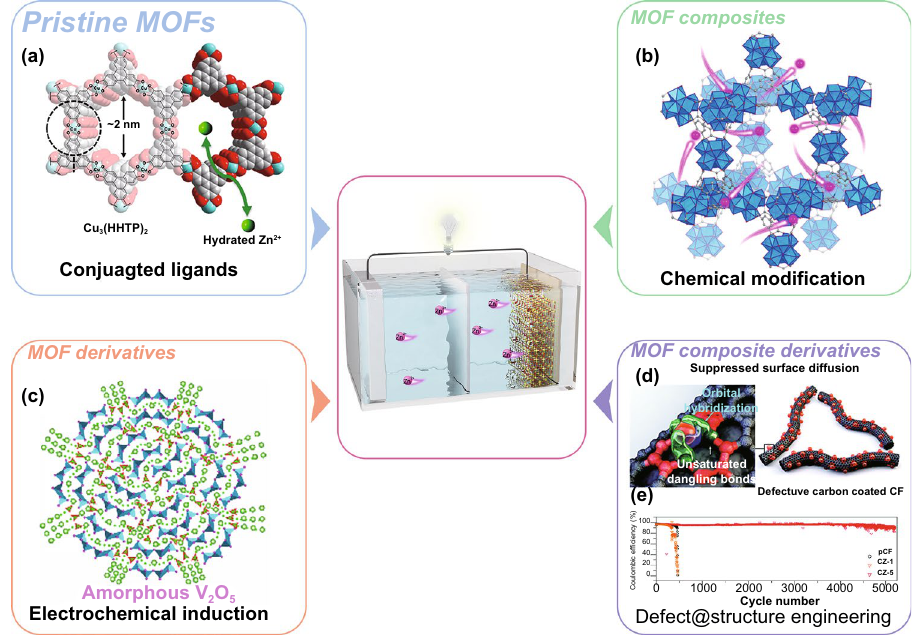
Fig. 5 MOF-based materials for ZIBs. a Crystal structure (the cyan, red, and gray spheres represent Cu, O, and C atoms, respectively) of Cu 3 (HHTP) 2 [164]. Copyright © 2019, Nature Publishing Group. b Crystal structure of ZnMOF-808. Blue polyhedrons represent Zr-O clusters and pink balls represent Zn 2+ ions [168]. Copyright © 2019, Elsevier. c Schematic illustration of Zn 2+ diffusion pathways and Zn 2+